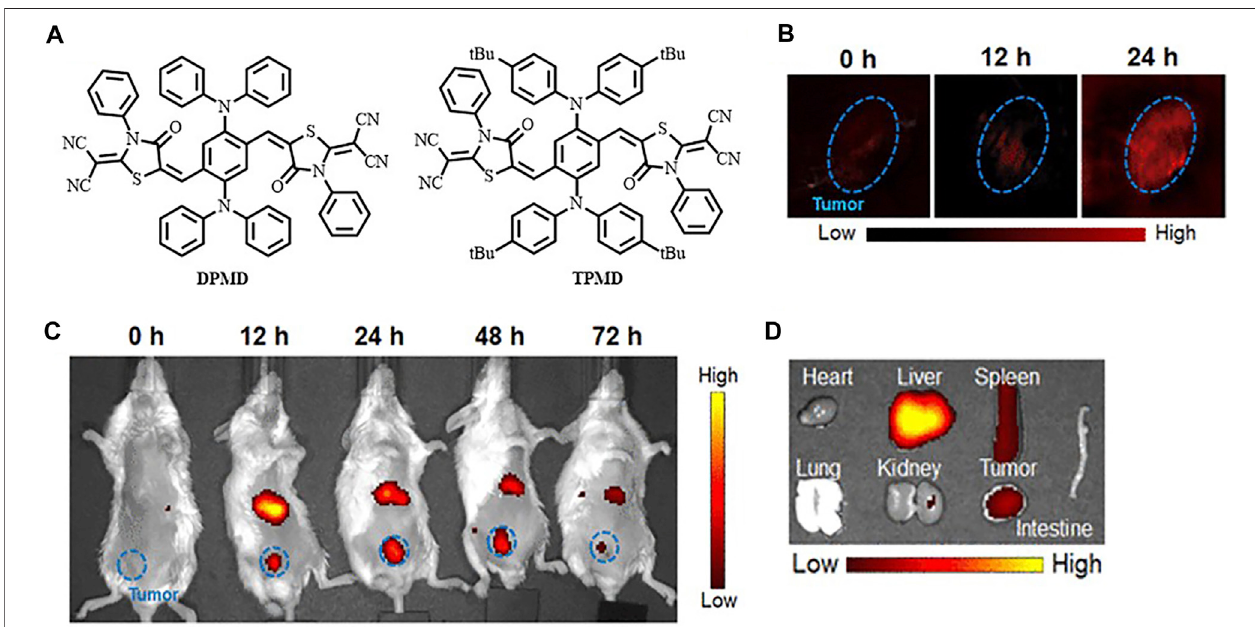
FIGURE13|(A) ChemicalstructuresofDPMDandTPMD. (B) Invivo PAIof4T1subcutaneoustumor-bearingmiceafterintravenousinjectionofTPMDNPs. (C) In vivo fl uorescence images at different time points. (D) Ex vivo FI of the tumor and major organs from the TPMD NPs-treated mice at 24 h postinjection. Reproduced with permission from Liu et al. (2021). Copyright 2021, American Chemical